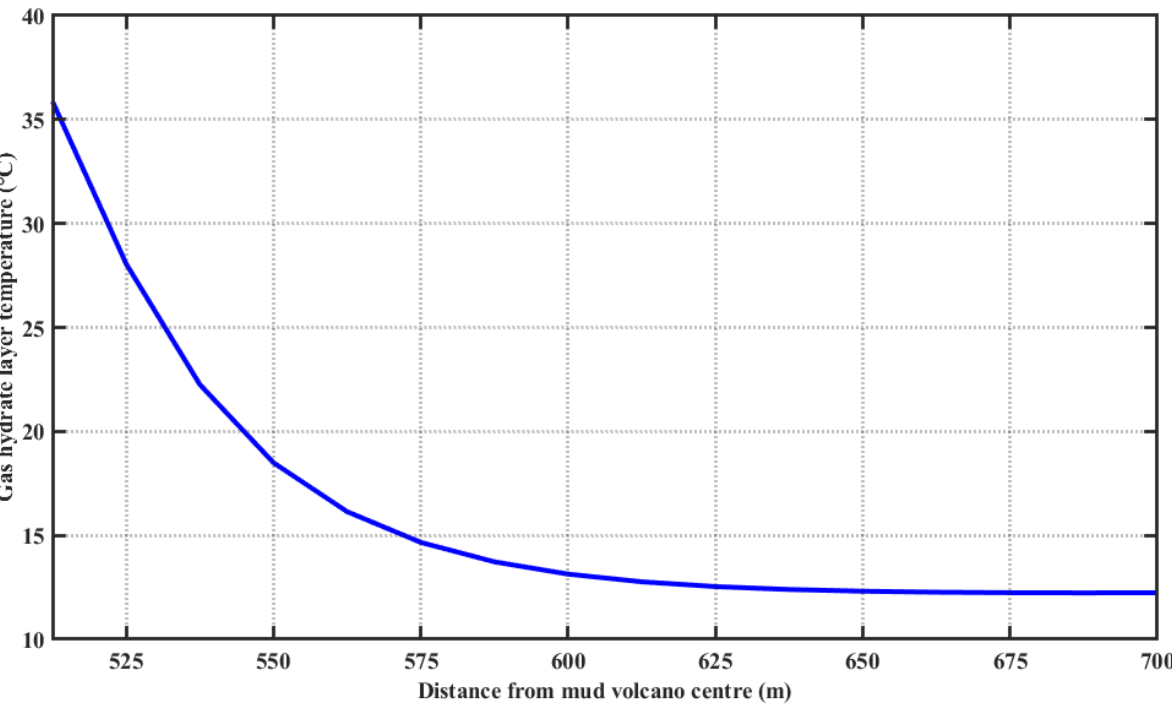
Figure 7. Variation curve of the hydrate layers’ temperature with horizontal distance from a mud volcano vent (temperature–distance curve). The thermal conductivity of hydrate layers and the related data are listed in Table 1.